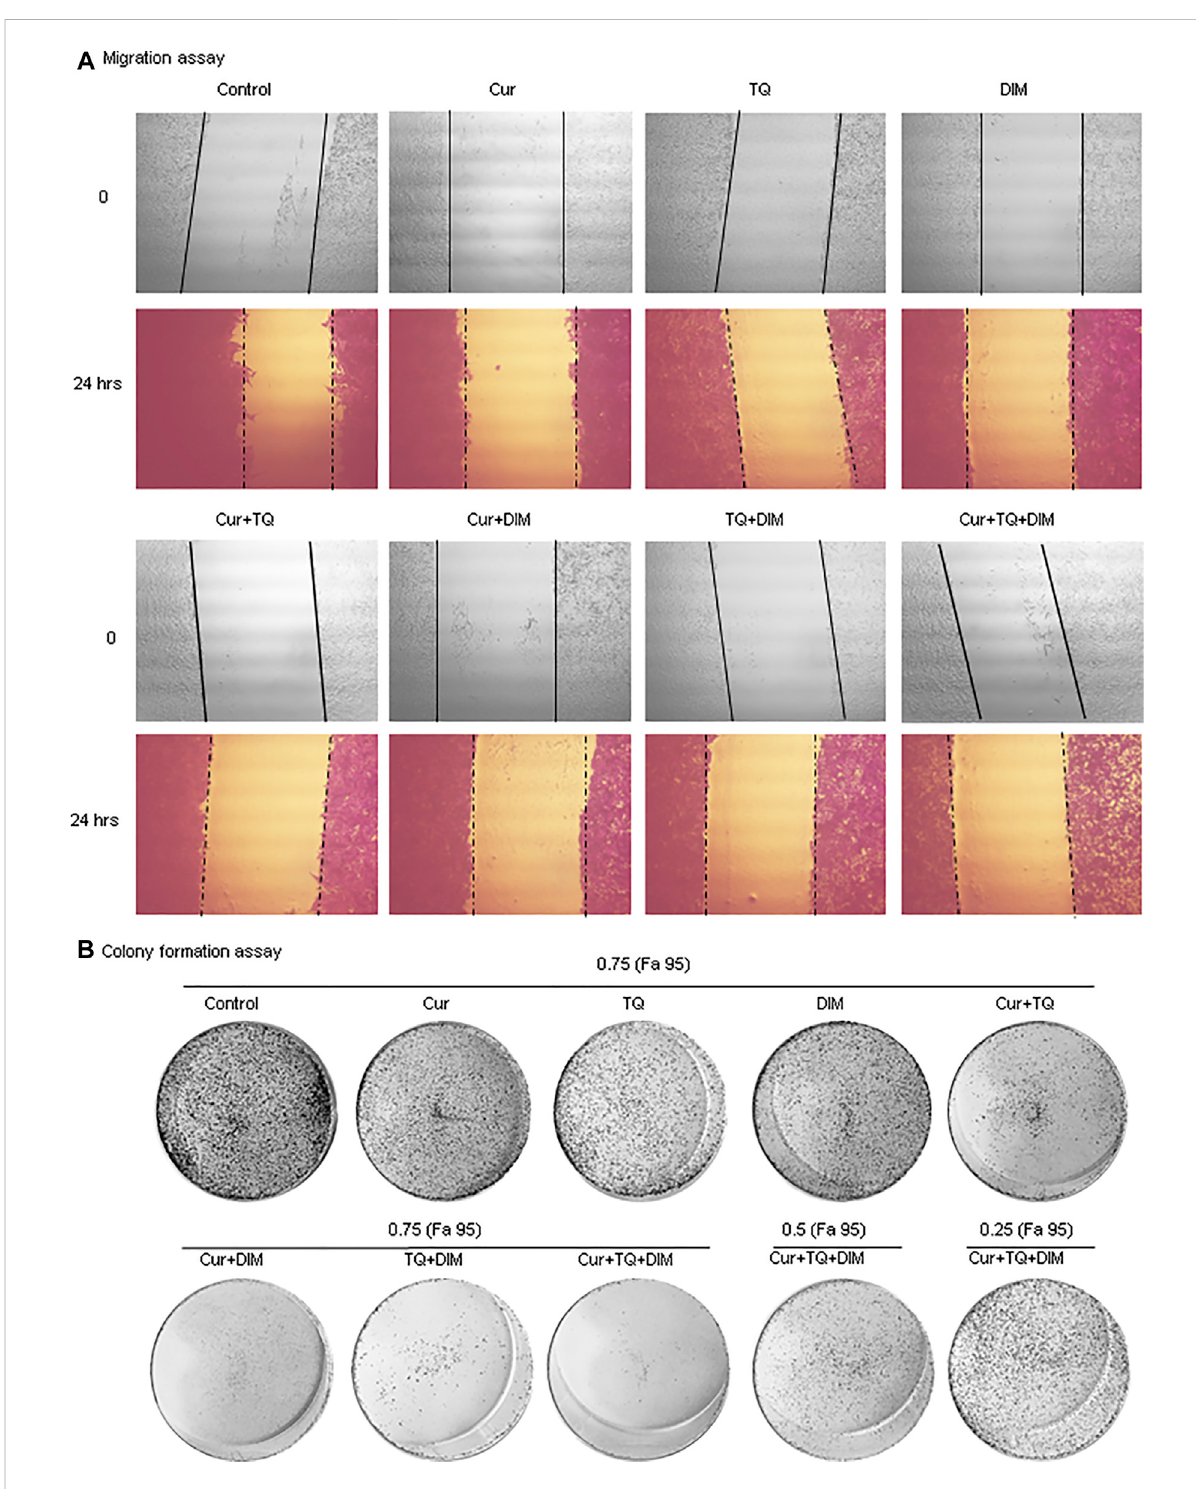
FIGURE 8 MigrationandcolonyformationassaysofHepG2. (A) MigrationassayofcontrolandHepG2-treatedwith0.75(Fa95)ofCur,TQ,DIM,Cur+TQ, Cur + DIM, TQ + DIM, and Cur + TQ + DIM at 0 and 24 h (B) colony formation assay of control, HepG2-treated with 0.75 (Fa 95) of Cur, TQ, DIM, Cur + TQ, Cur + DIM, TQ + DIM, and Cur + TQ + DIM, HepG2-treated with 0.50 (Fa 95) of Cur + TQ + DIM, and HepG2-treated with 0.25 (Fa 95) of Cur + TQ +